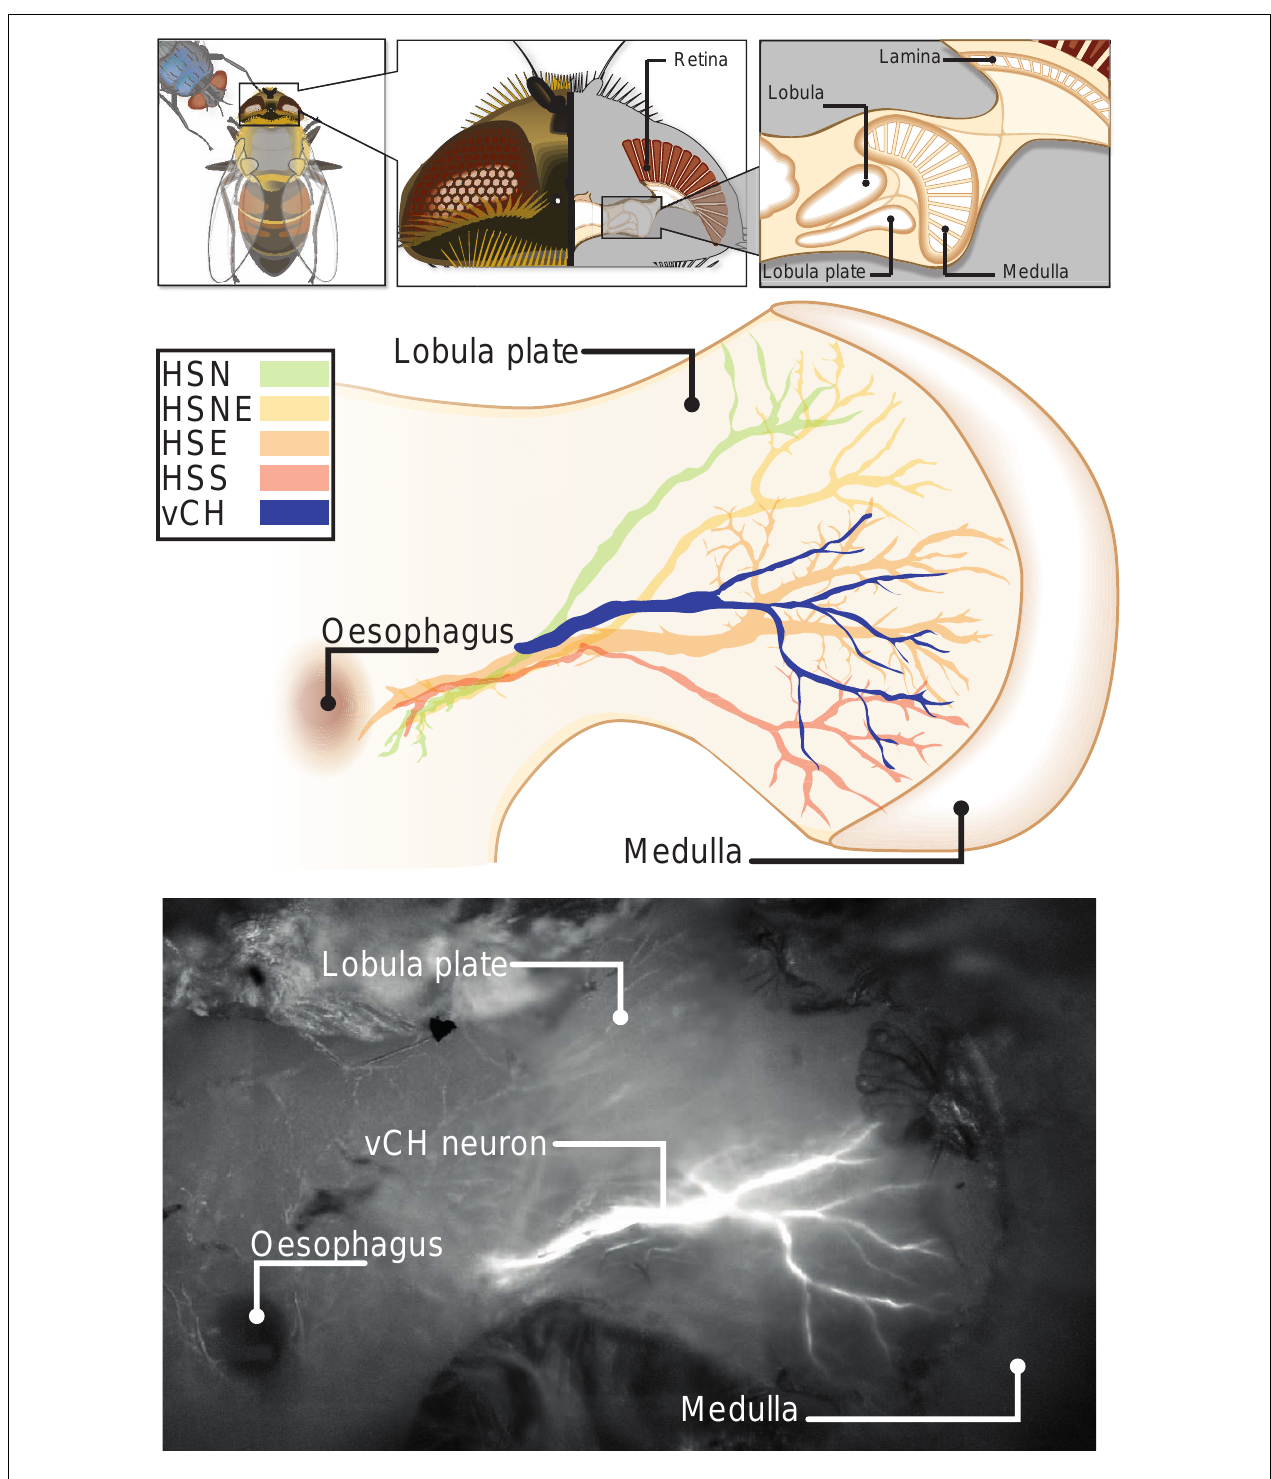
( z -projections) of the cells’ main arborizations were copied by hand into vector graphics.The horizontal system (green, yellow, orange, red) was plotted to give relative position of the vCH (blue). In the bottom row a z -projection of the vCH cell is superimposed on a wide-field image of the fly’s